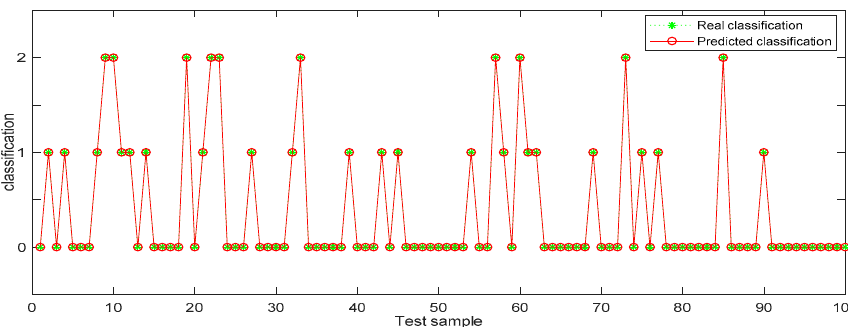
Figure 7. Random forest identification results from dataset 1.